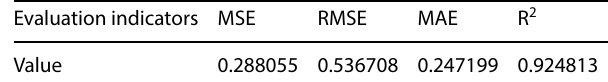
Table 6 Model evaluation results Evaluation indicators MSE